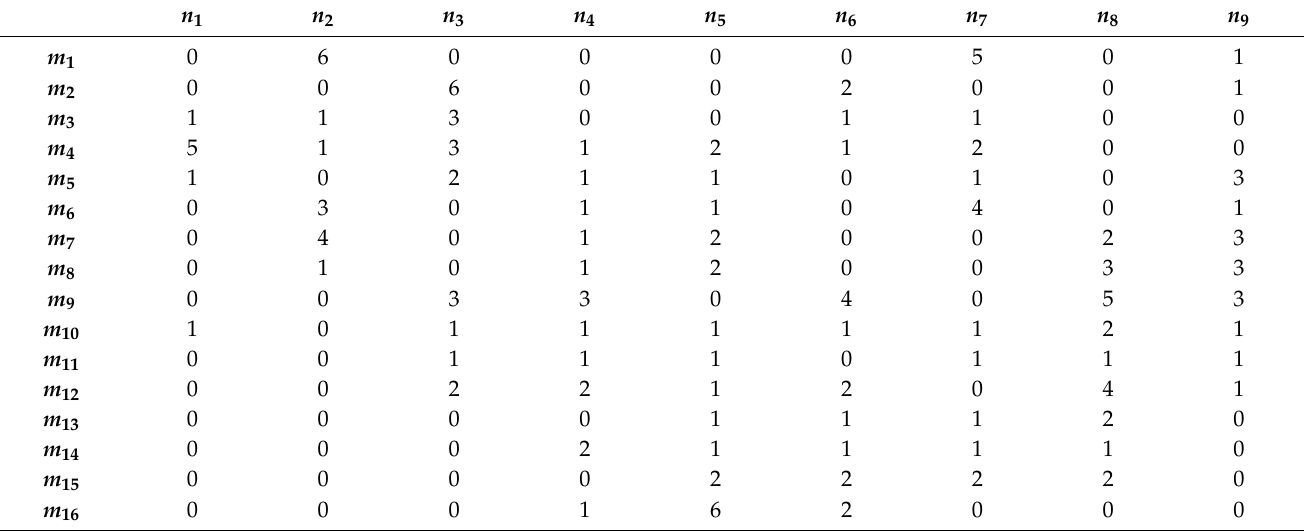
Table 7. Values of decision variables (Variant #1, MS